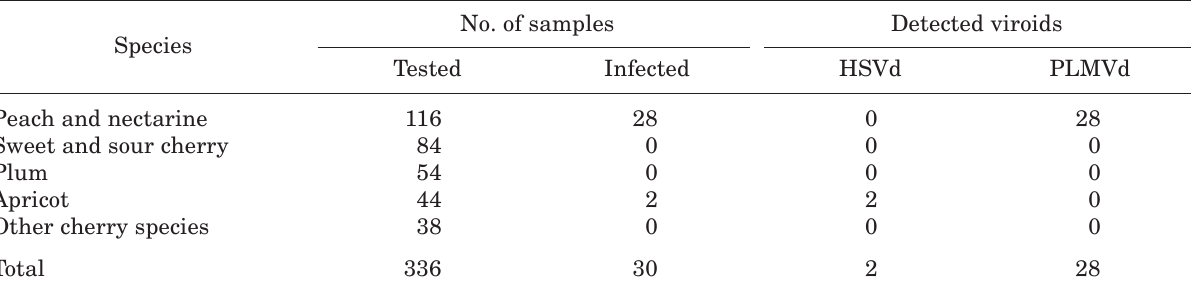
Total (20.3%) Table 2. Viroids detected by molecular hybridisation in Clonal Genebank Prunus accessions (Harrow, Canada).